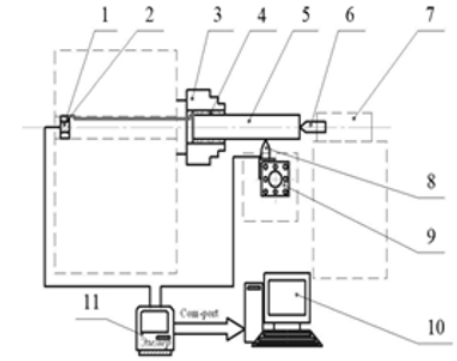
Fig. 2. Scheme of temperature measurement by natural thermocouple method. 1 - mercury current collector; 2, 4 - insulation; 3 - cartridge; 5 - blank; 6 - isolated back center; 7 - tailstock; 8 - tool holder; 9 - cutter with insulation; 10 - computer; 11 - digital voltmeter